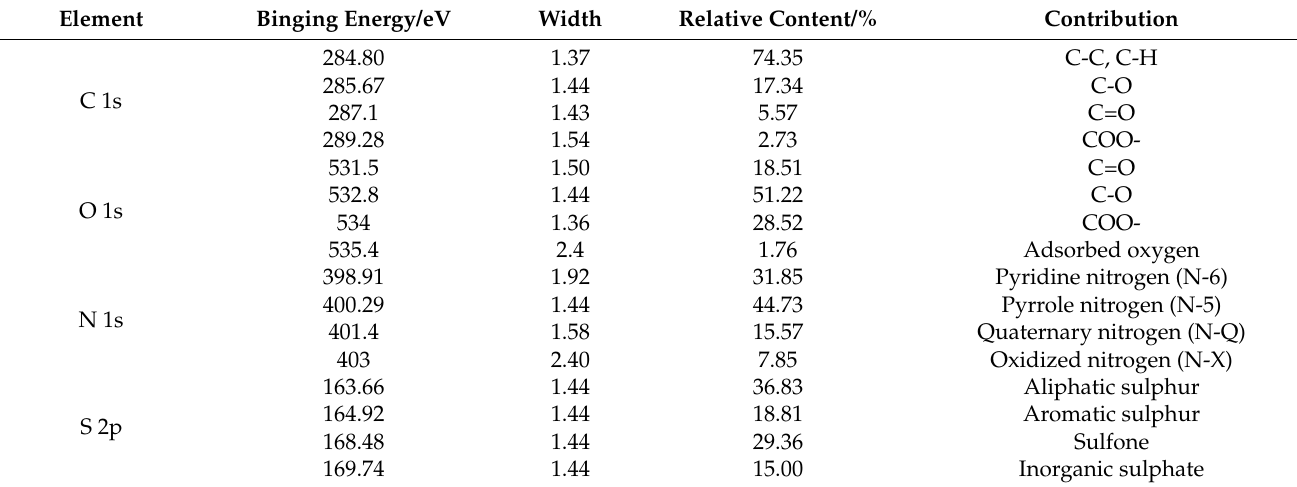
Table 4. Curve-fitted XPS of Kerjian